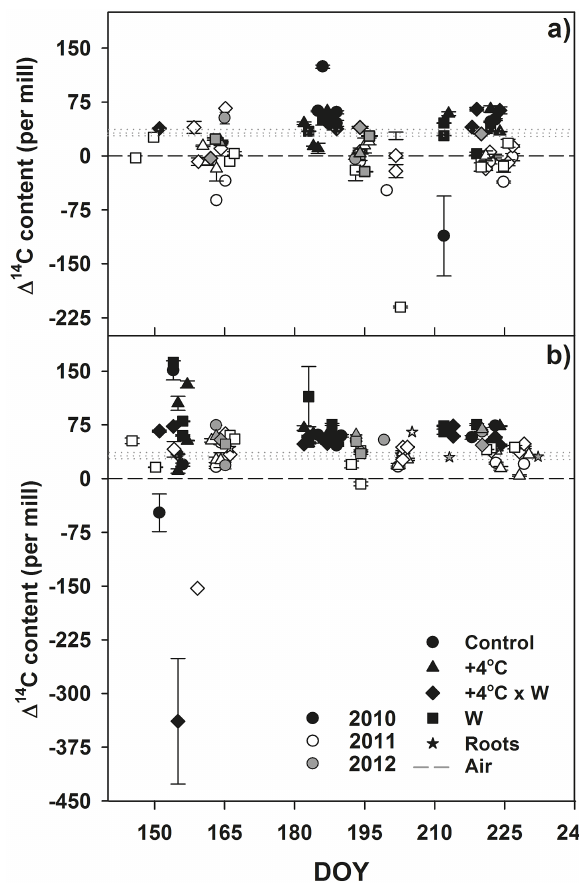
Figure 4. Radiocarbon content (per mill) of R eco from bare (a) and vegetated (b) areas for three treatments ( + 4 ◦ C, + 4 ◦ C × W and W ) and control over the sampling years 2010–2012. (Dotted lines indi- cate the range of 14 CO 2 in ambient air, star symbols represent root respiration in control areas.)